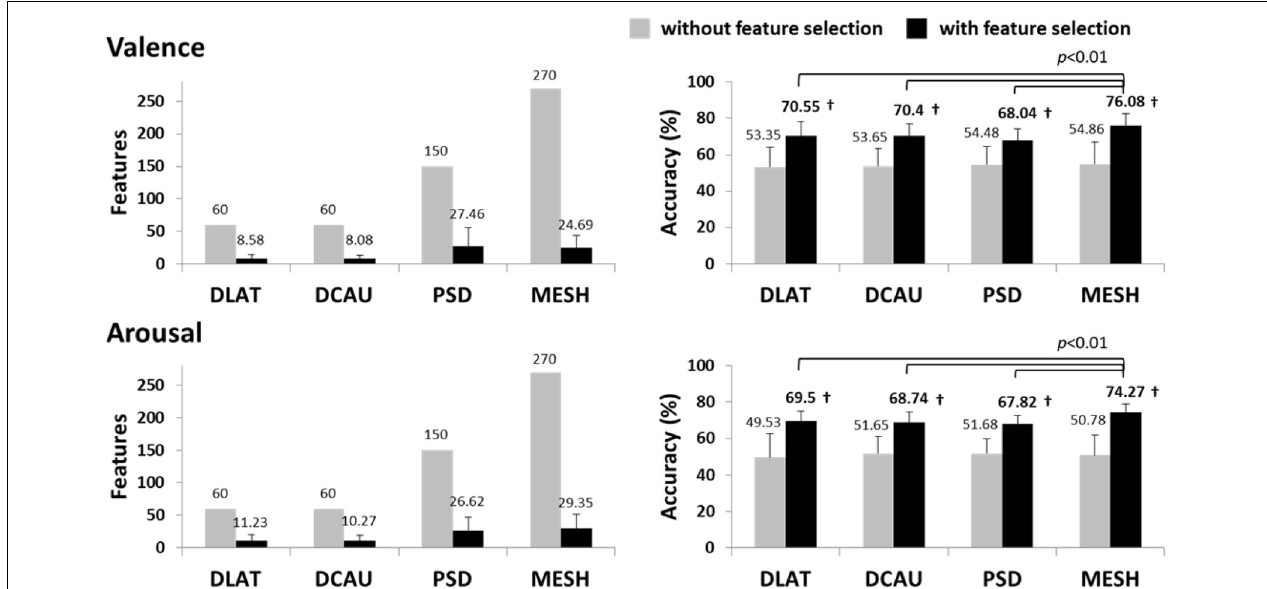
FIGURE 2 | The valence and arousal classification results using the subject-dependent EEG feature sets with/without the F-score based feature selection. The numbers above the bars represent the mean values of the results, whereas the numbers in bold indicate the